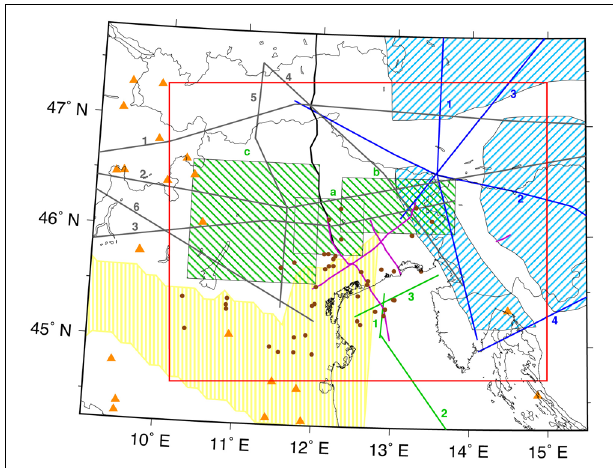
FIGURE 2 | Location of the various data used as input within the area of the model (red rectangle). Gray lines – seismic profiles from Scarascia and Cassinis (1997) (1: Alp75; 2: Lago Bianco – Lago Lagorai – Tarvisio – east; 3: SudALP; 4: Eschenlohe – Trieste; 5: Eschenlohe – Euganei Hills; 6: Lago Bianco – Euganei Hills); black line – TRANSALP seismic profile (Castellarin et al., 2006); blue lines – ALP 2002 project profiles (1: Alp01, 2: Alp02 from Brückl et al., 2007; 3: CEL10/Alp04 from Grad et al., 2009a; 4: Alp07 from Šumanovac et al., 2009); green lines – seismic profiles from CROP (1: M-17A, 2: M-17B, and 3: M-18 from Finetti and Del Ben, 2005); purple lines – seismic lines from Fantoni et al. (2003) and Nicolich et al. (2004); area filled by light blue lines – Moho map of Behm et al. (2007) orange triangles – stations with receiver functions; area filled by yellow lines – depth of sediments from the model of Vuan et al. (2011); brown circles – position of boreholes (Nicolich et al., 2004; Cimolino et al., 2010; ViDEPI, 2015); area filled by green lines – local earthquakes tomographies (a: Anselmi et al., 2011; b: Bressan et al., 2012; c: Viganò et al.,